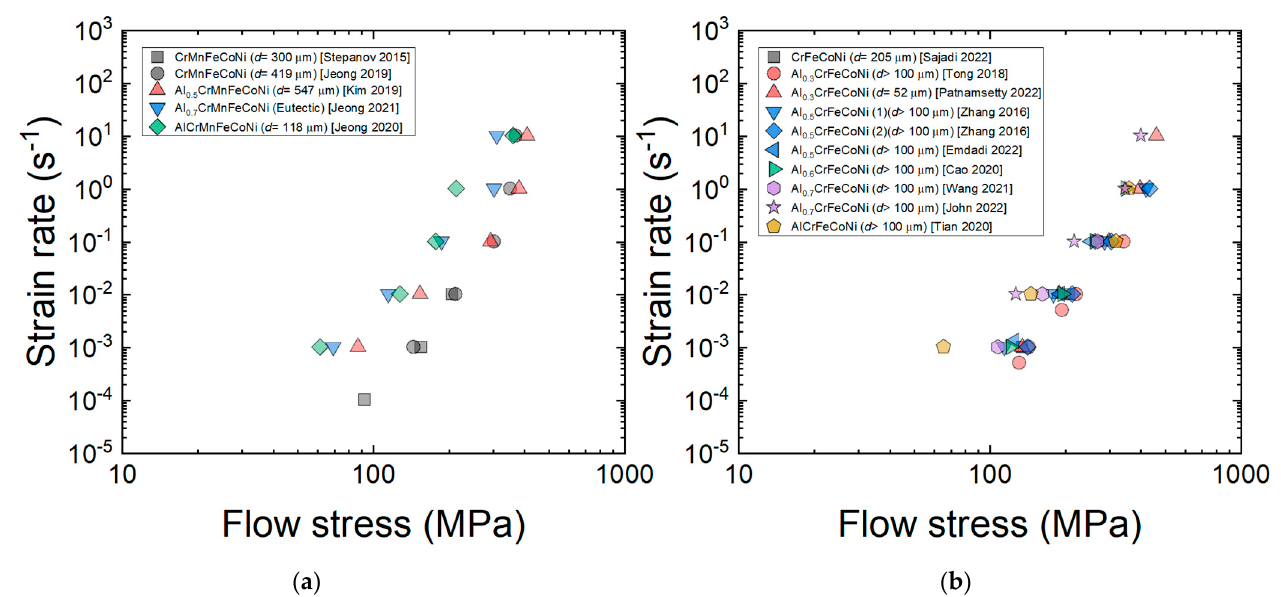
Figure 5. Plots of the log ε − log σ curves for the ( a ) Al x CrMnFeCoNi ( x = 0–1) [9,27,34,42,63] and ( b ) Al x CrFeCoNi ( x = 0–1) [13,25,51,53,72,84,92,96] HEAs at a given temperature of 1173 K (at a strain of 0.5).